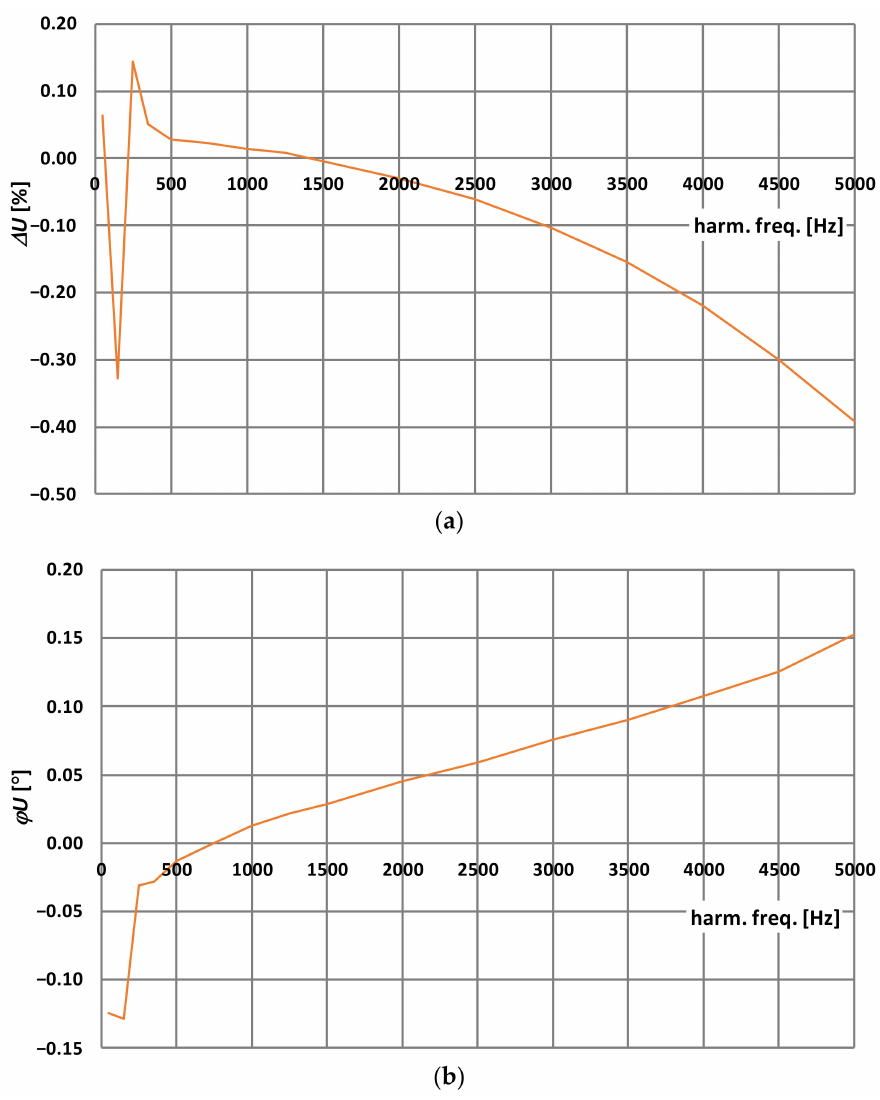
Figure 9. Comparison of the transformation accuracy of harmonics determined between two units of √ the (15/ 3) kV inductive VTs: ( a ) voltage error, ( b ) phase